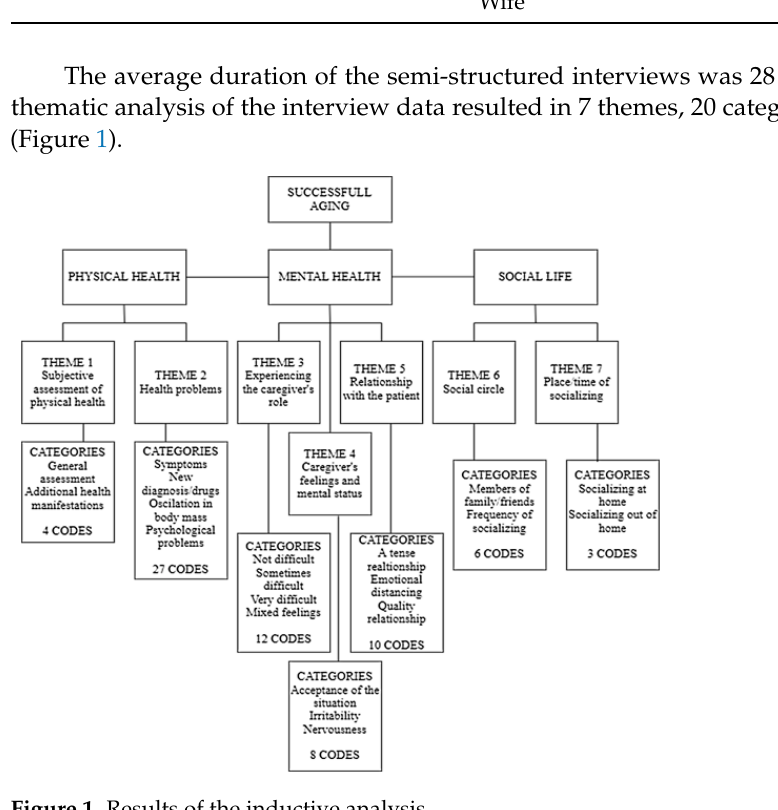
Figure 1. Results of the inductive analysis.